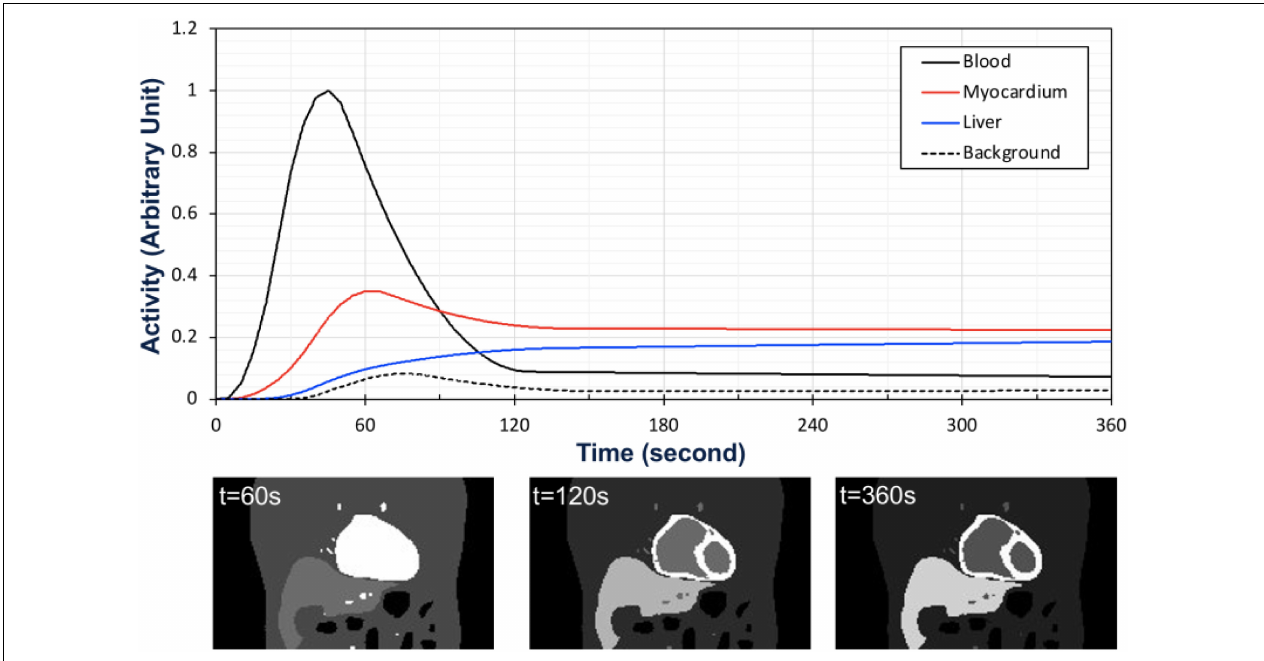
FIGURE 3 | Time activity curves used for the activity map (top) and the corresponding coronal views of the activity distribution in the phantom at time t = 60 s, t = 120 s, and t = 360 s (bottom).